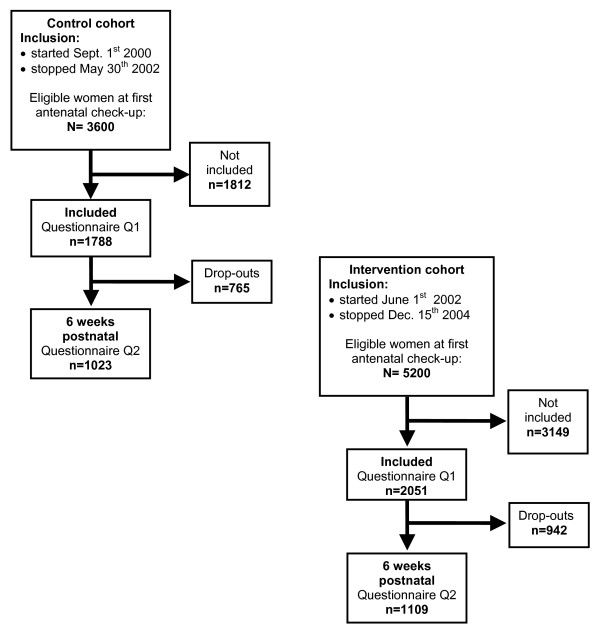
Flow chart. The same questionnaires were used in both cohorts. Q1 = questionnaire during pregnancy, measurement of smoking behaviour at start pregnancy and at inclusion at first antenatal check-up. Q2 = questionnaire at six weeks postnatal, measurement of present smoking behaviour.